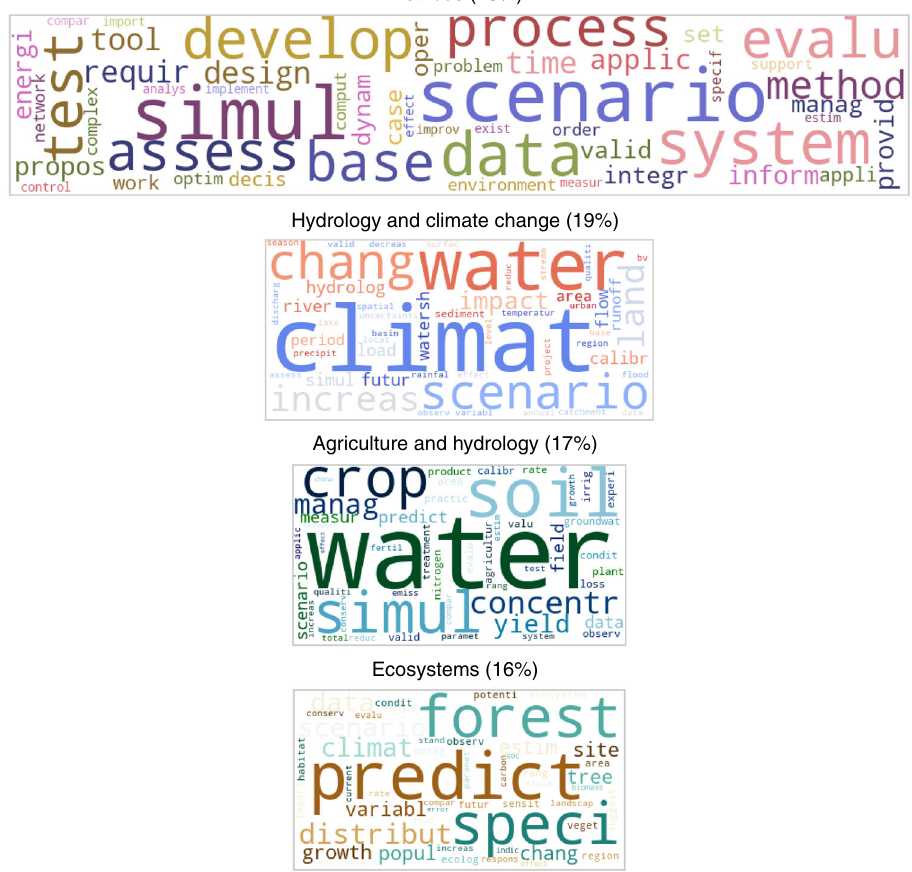
Fig. 2 The four topics in the validation and scenario publications. The fi gure shows the four topics identi fi ed by the application of a topic modelling algorithm (Latent Dirichlet Allocation) on the publications in Dataset II, which contains the scenario-oriented studies in particular in addition to model validation. The word clouds depict the top 50 most frequent, hence the most descriptive words associated with each topic. The size of each cloud is respective to the fraction of publications associated with the corresponding topic. In each word cloud, the bigger the font of a word, the more descriptive it is for the corresponding topic. Considering the word content, the Methods topic focuses on simulation, (model) development, evaluation and testing. Data is a descriptive word again, and uncertainty is not among the top fi fty words, although it is expected to be an important concept in scenario studies. The other three topics again refer to the main areas of sustainability science. Scenario approaches are more apparently associated with Hydrology and Climate Change studies, while the Ecosystems studies emphasise prediction. Source data of this fi gure are provided in Supplementary Data